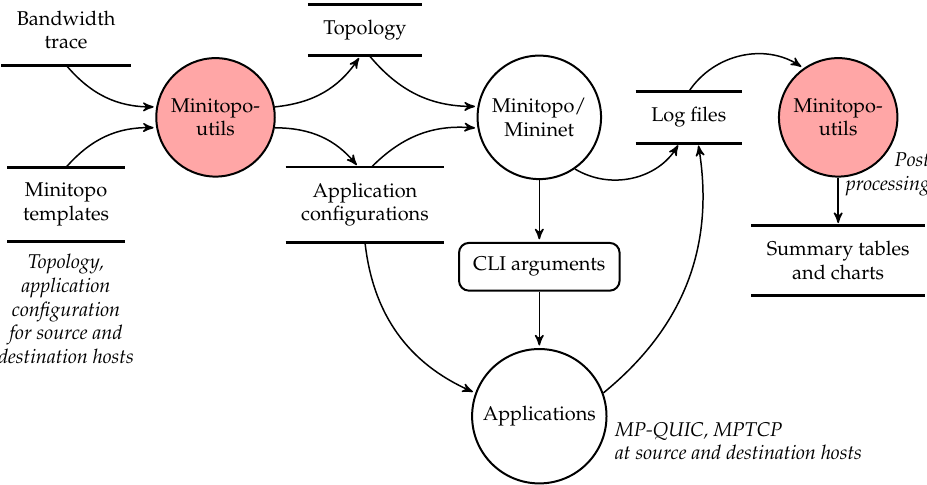
Figure 5. High-level internal operation of the emulation environment as a data-flow diagram.